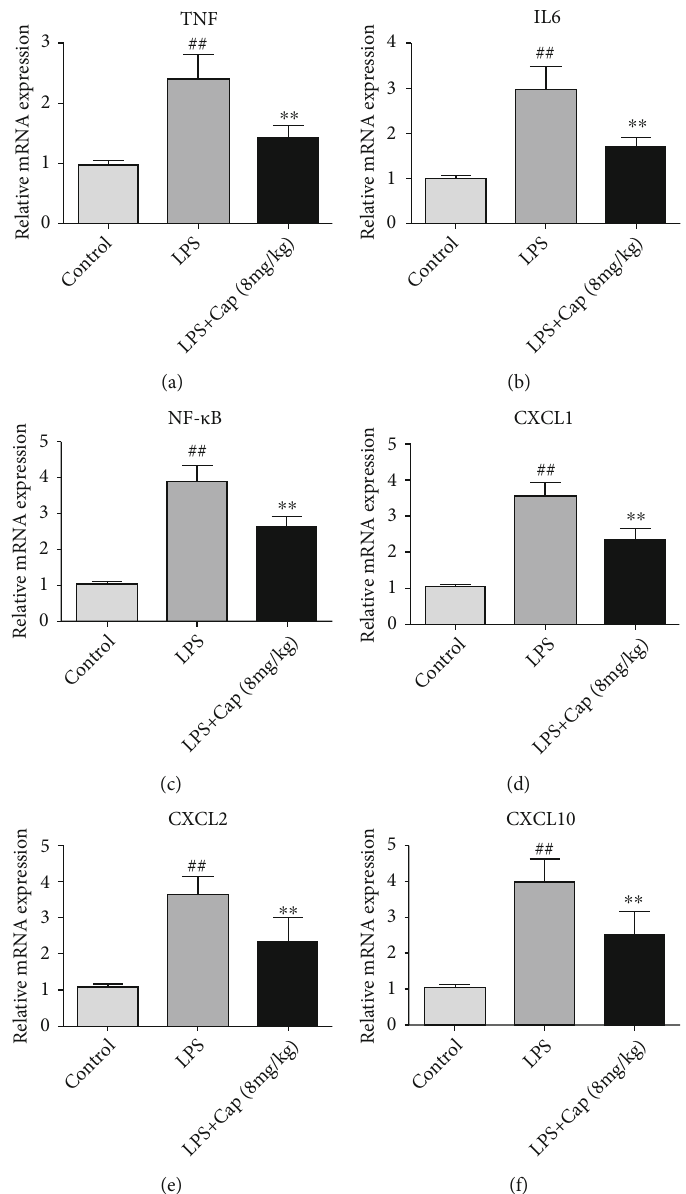
Figure 9: Cap downregulated in fl ammation-related gene expression in neonatal rats with acute lung injury. The mRNA expression of TNF (a), IL-6 (b), NF- κ B (c), CXCL1 (d), CXCL2 (e), and CXCL10 (f) in lung tissue. Results are expressed as the mean ± standarddeviation ( n = 6 ). ## P < 0 : 01 compared to the control group; ∗ P < 0 : 05 and ∗∗ P < 0 : 01 compared to the LPS